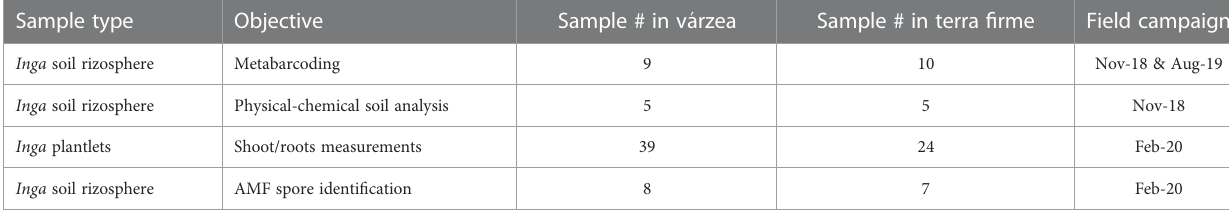
TABLE 1 Overview of the sample collection at the Tiputini Biodiversity Station during three sampling campaigns.